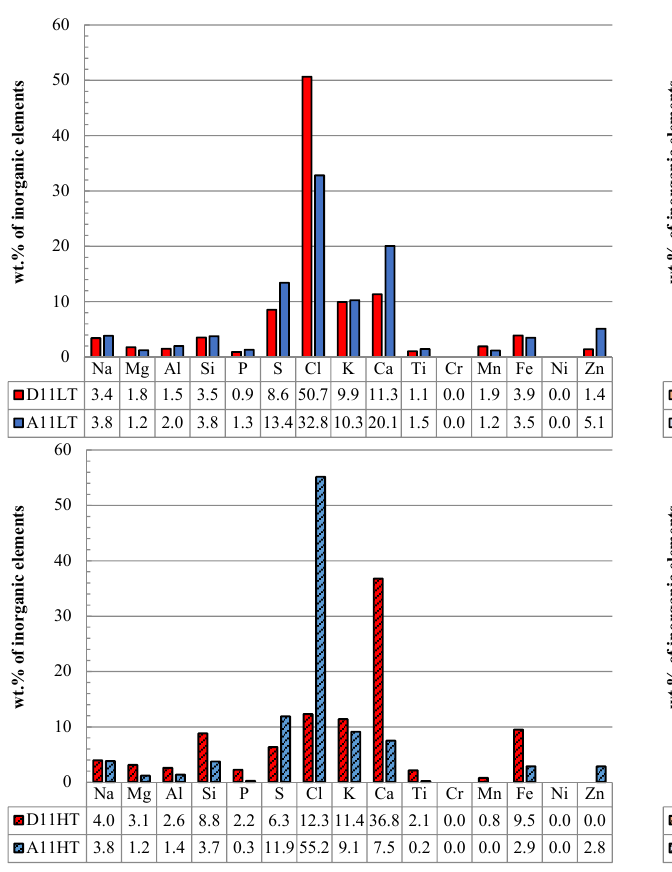
Figure 9. SEM-EDS results of (D) deposited and (A) adhered fouling samples from combustions with a total airflow of (11) 11 m 3 /h and (25) 25 m 3 /h with a primary air distribution of 25% and a secondary air distribution of 75% and two different deposition probe temperatures: 20–25 °C (LT) and 60–65 °C (HT). C and O were eliminated and the rest of the inorganic elements were normalized to